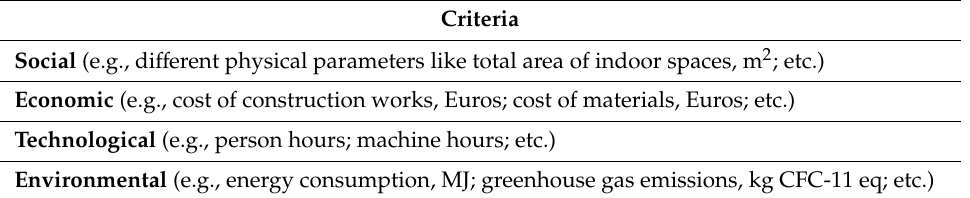
Table 1. Proposed set of criteria for the sustainability assessment of alternative structural solutions. Criteria